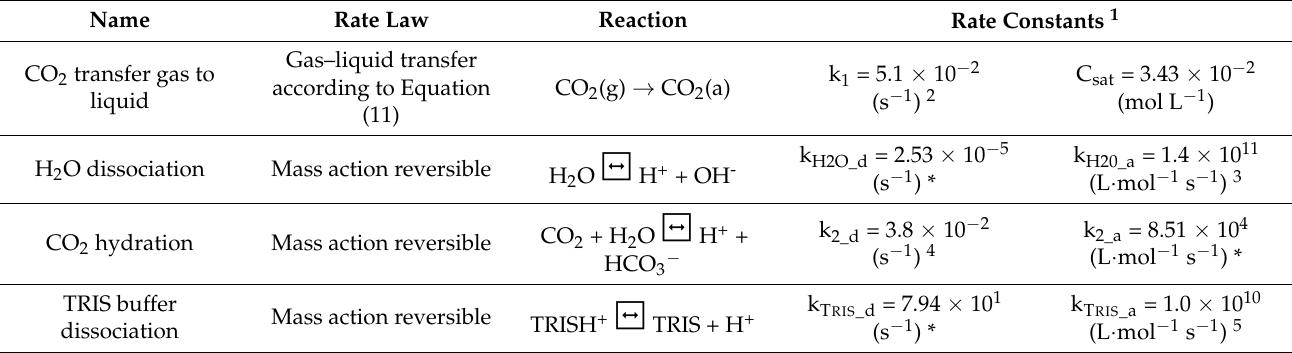
Table 1. Types of reaction, rate laws and constants used for modeling the timely behavior of chemical species.